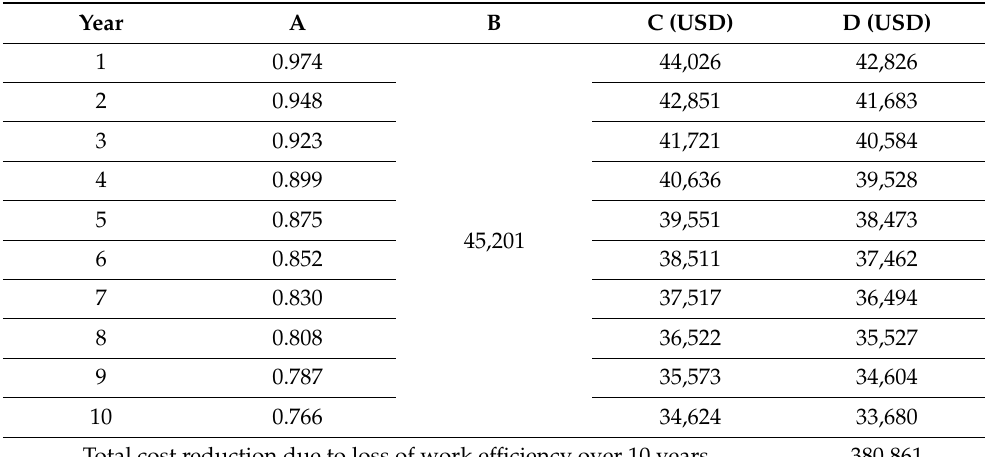
Table 4. Decrease in work efficiency by applying the present value coefficient to 10 people (currency: